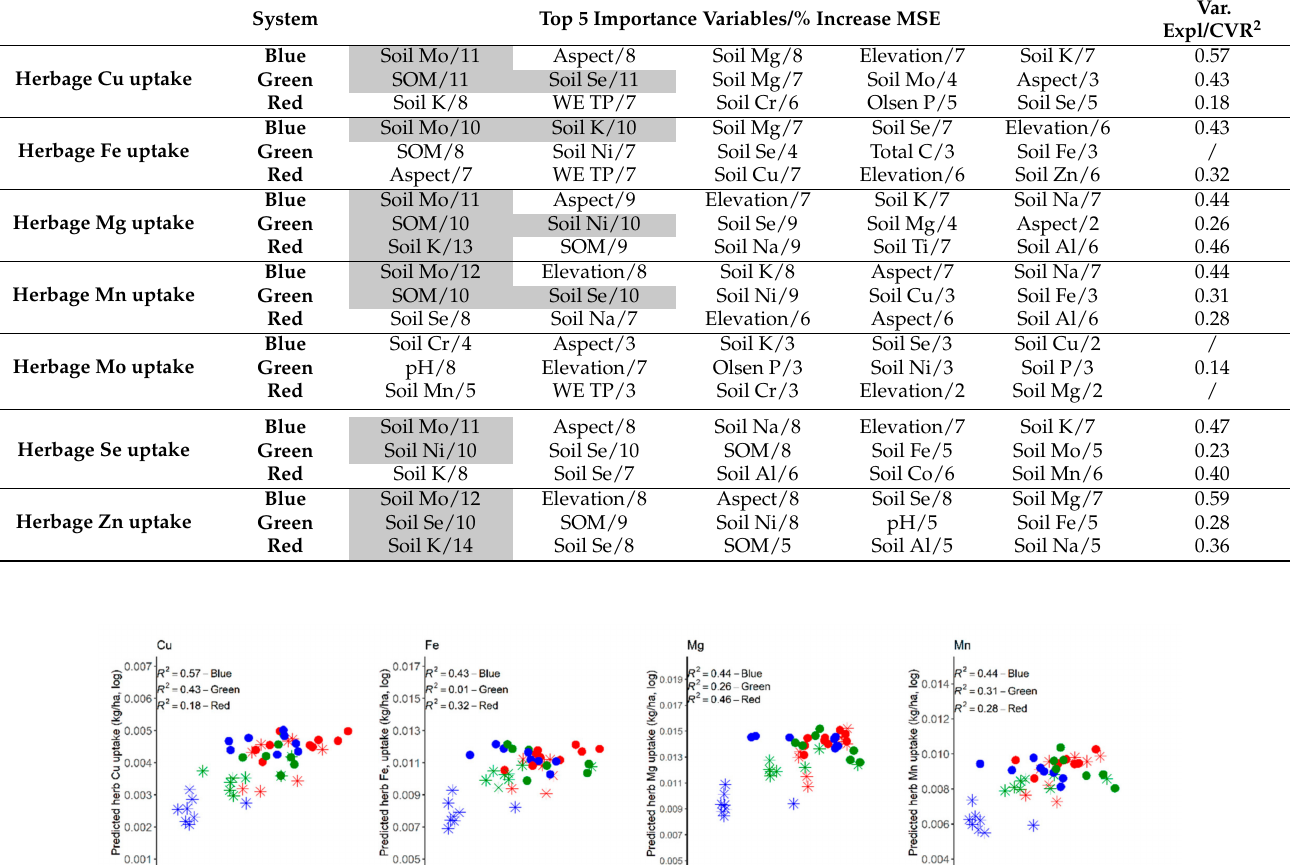
Table 5. Cross-validation performance of the site/soil calibration models predicting herbage micro-nutrient uptake (concentration × yield) in the blue/HSG + L, green/P + N and red/HSG + N pasture systems: % Inc. MSE (how much model accuracy decreases if the variable is excluded), and total % variance explained by each model (CVR 2 ). Showing only the top 5 ranked variables. Variables in the model were: elevation, aspect, slope, total N, total C, Olsen P, WE PO4, WE TP, SOM, BD, pH and soil total Al, Ca, Co, Cr, Cu, Fe, K, Mg, Mn, Mo, Na, Ni, P, S, Se, Ti and Zn concentration. Dark grey highlight ≥ 10% increase in MSE when excluded from the model.